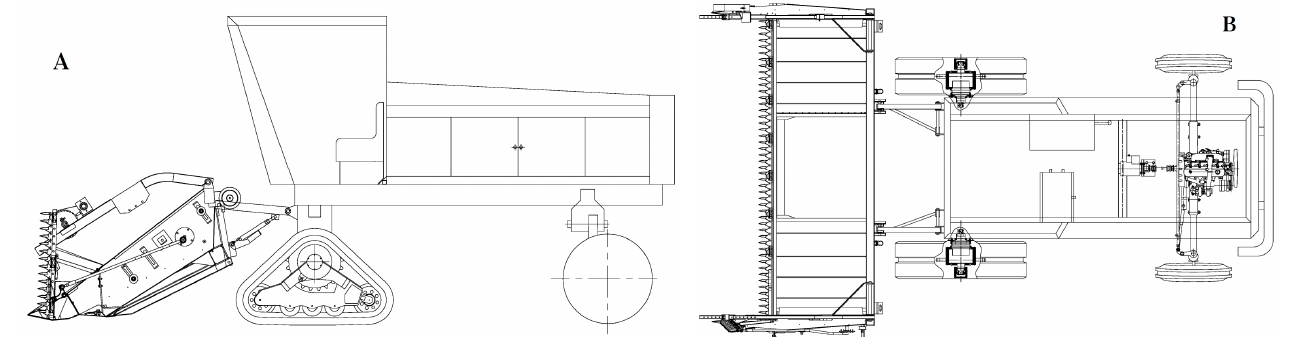
Figure 1. Structural diagram of a wheel-track high clearance rape windrower. ( A ) Main view; ( B ) Vertical view (removal of cab and frame top cover).